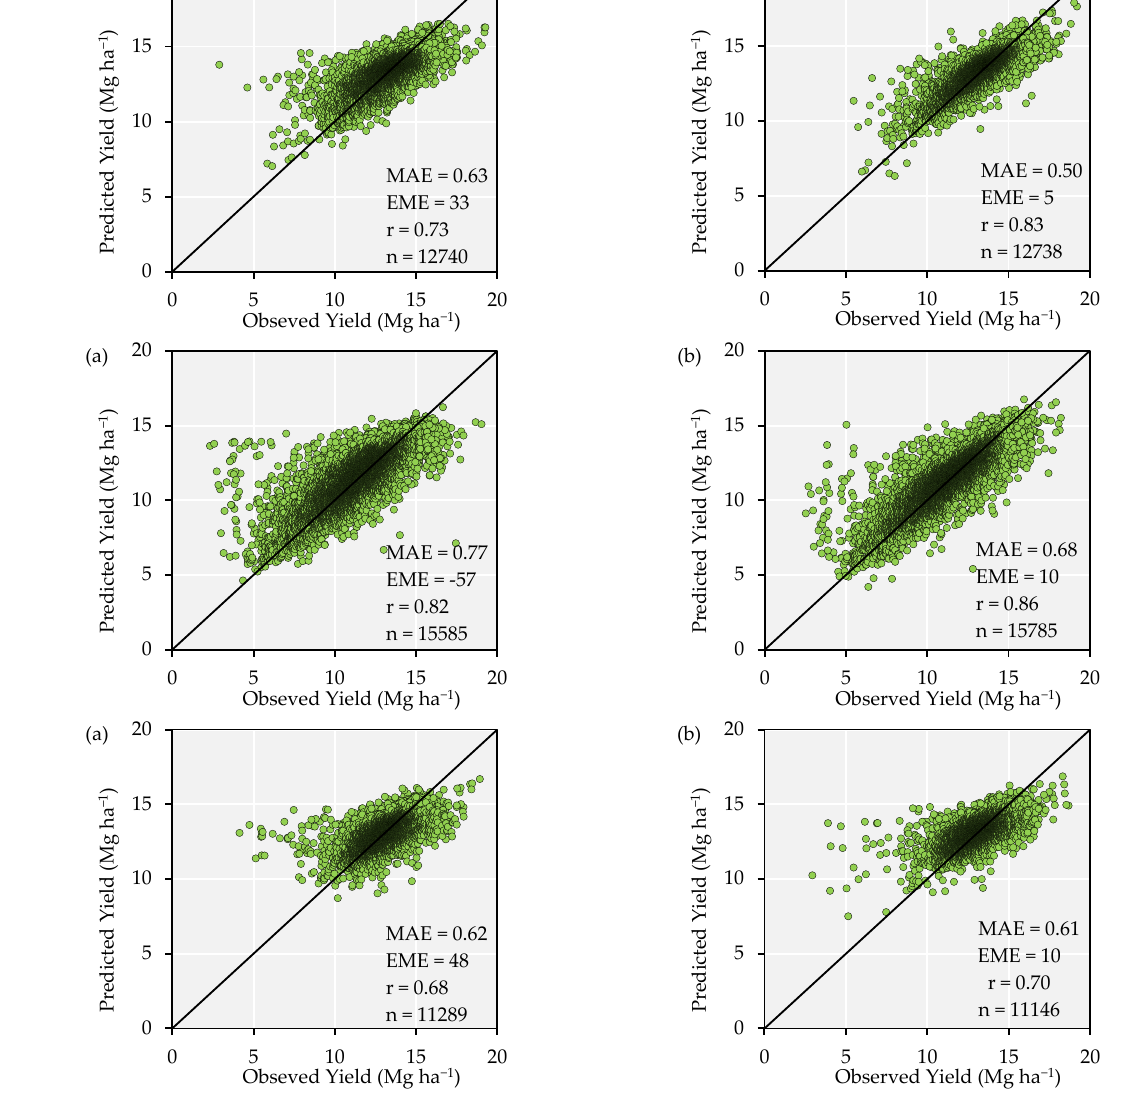
Figure 12. Performance analysis of test dataset with the features spectral bands + TPI + TWI in two approaches of model calibration, ( a ) whole-field and ( b ) site-specific models, in the scenario of all seasons combined. Observation: MAE (mean absolute error) is expressed in Mg ha −1 , EME (estimative mean error) in Kg ha −1 , and r is the correlation coefficient.